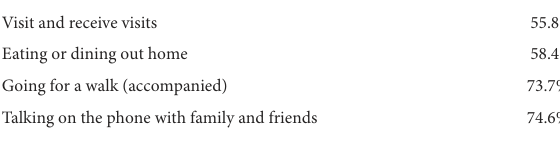
TABLE 3 Daily activities from the age of 65-year-old and above. Visit and receive visits Eating or dining out home Going for a walk